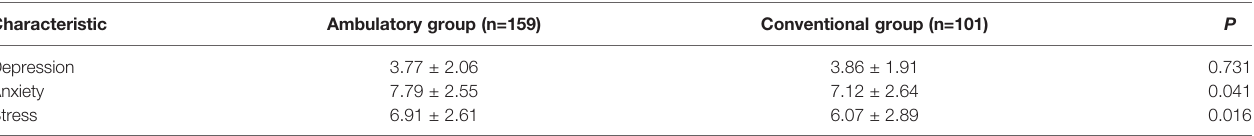
TABLE 4 | Results of